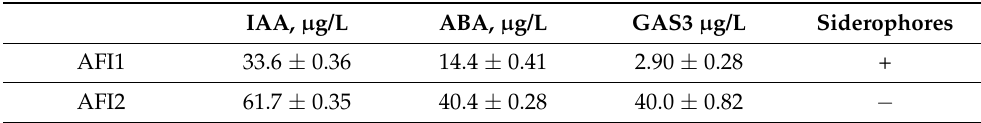
Table 1. Phytohormones and siderophores productions by PGPB